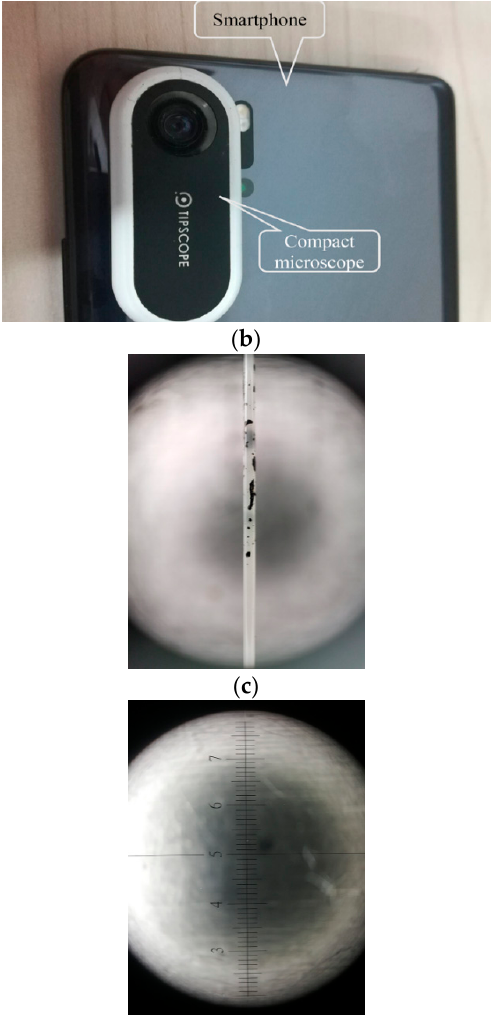
Figure 1. Schematic illustration of the ( a ) test, ( b ) compact microscope, ( c ) marker of optical fiber, and ( d ) micrometer imaged by the smartphone with a microscope.